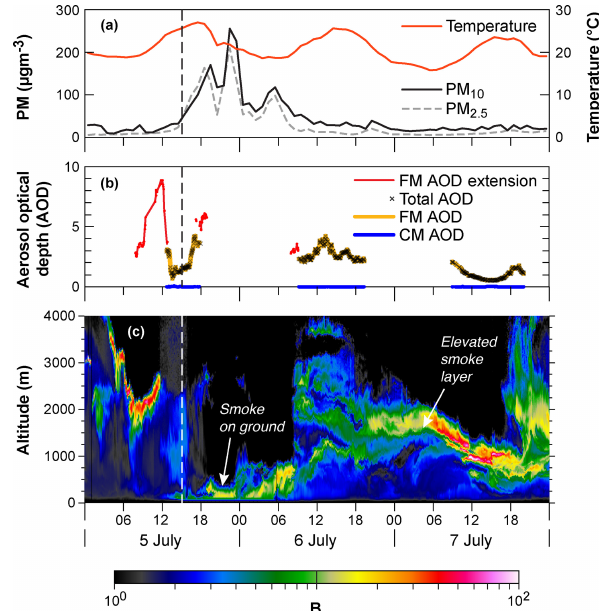
Figure 3. Time series for 5–7 July 2017 showing (a) PM 2 . 5 and PM 10 observations and temperature at Vancouver International Air- port, and (b) aerosol optical depths for fine-mode (FM) and coarse mode (CM) variation at Saturna Island. The “FM AOD extension” was obtained by assuming that the total AOD at the longer wave- lengths of 675 and 870nm was dominated by the fine-mode AOD and extrapolating their AODs back to 500nm (a choice necessitated by the fact that the extraordinarily large AODs at the shorter wave- lengths were eliminated by AERONET processing), and (c) LiDAR backscatter from the UBC CORAL-NET site at 532nm for the pe- riod. The red vertical line shows arrival of the low-level wall of smoke around 15:00PDT on 5